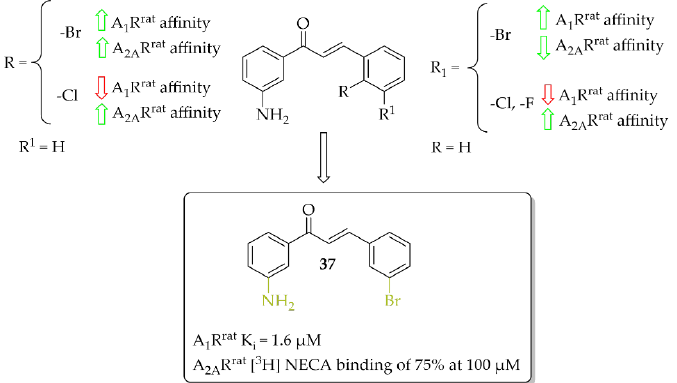
Figure 28. Aniline-based chalcones and the most active compound in the series